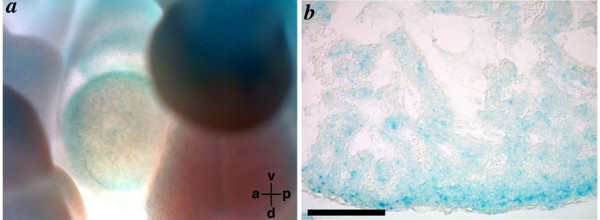
Analysis of Ptdsr expression in the embryonic heart (a, b) Staining of heterozygous Ptdsr-βgeo-embryos [21] using X-Gal at 10.5 dpc (a) and 11.5 dpc (b). (a) At 10.5 dpc Ptdsr expression can be seen throughout the heart. (b) Transverse sections of X-Gal stained embryos at 11.5 dpc showed an increased expression of Ptdsr in the myocardial wall and a beginning decrease of the expression in the trabeculation. Scale bar = 100 μm in (b).